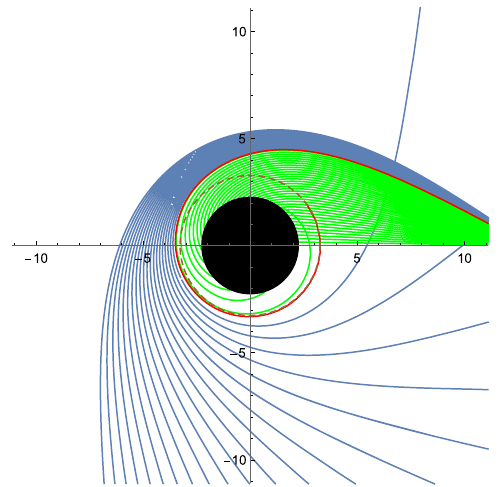
Fig. 2 The trajectories of the light ray for w = − 0 . 5 (left) and w = − 0 . 7 (right) with M = 1, a = 0 . 05. They are shown in the polar coordinates ( r ,ψ) . The red lines, green lines and blue lines cor-